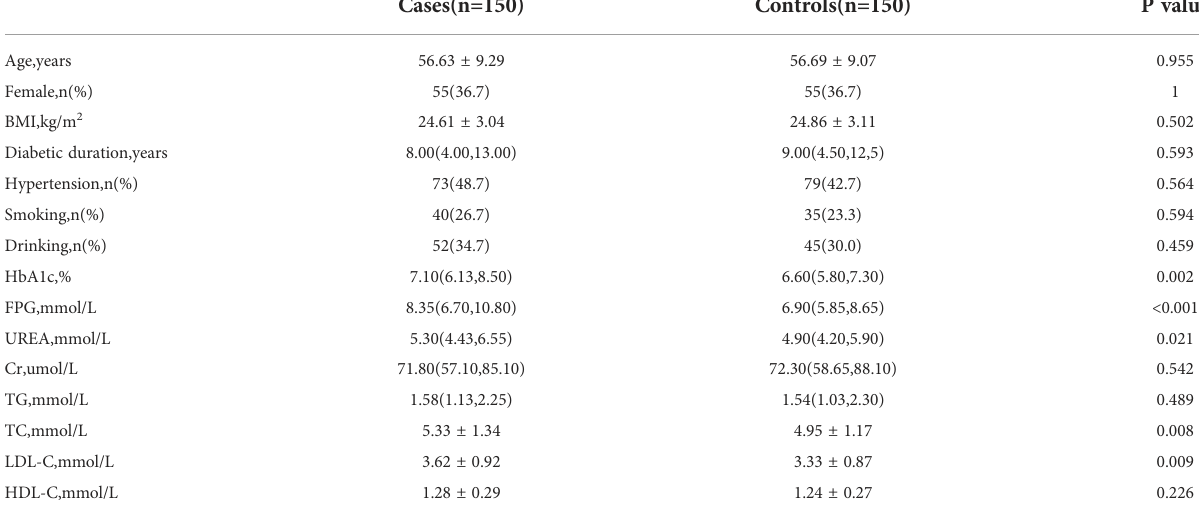
TABLE 2 Clinical characteristics of